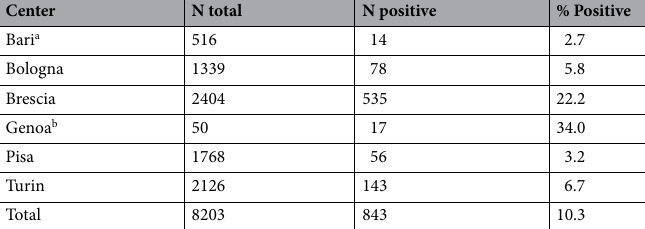
Table 3. Prevalence of SARS-CoV-2 infection among HCWs, by center. a Excluding 2451 HCWs and subcontract workers who were tested outside high-risk protocol (12 positive results; 0.5%). b Medical school faculty and residents, among 881 HCWs under